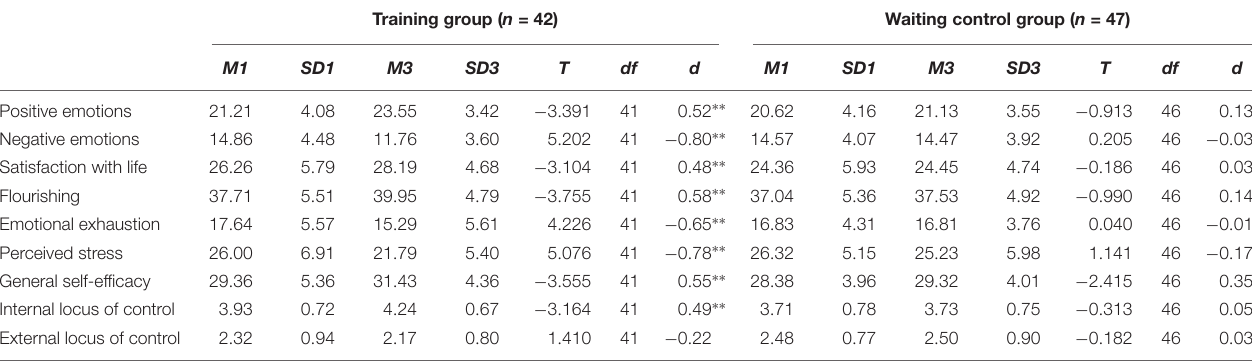
TABLE 5 | Within-group training effects 1 month after training (pre – follow-up1).